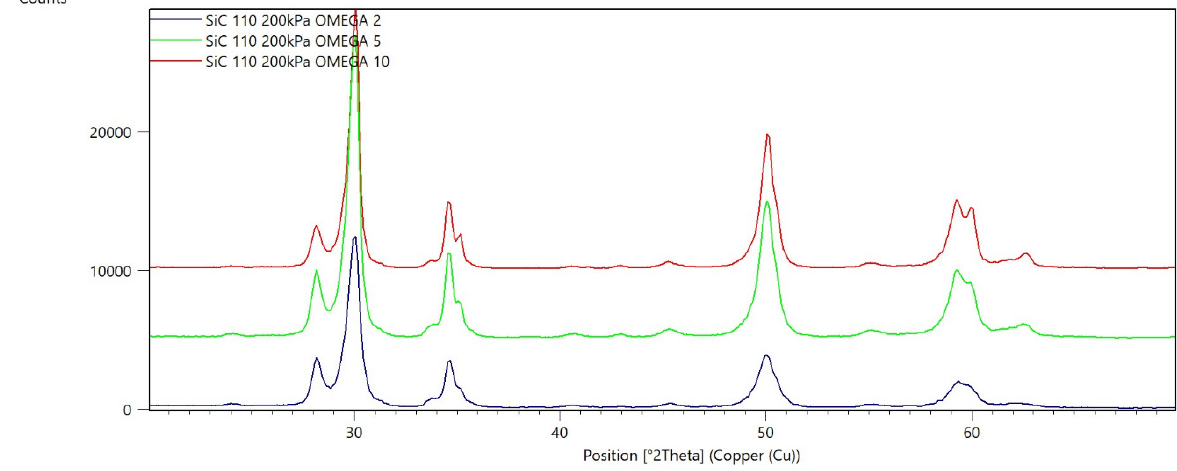
Figure 10. Diffraction patterns of sample I (abrasive—SiC 110 µ m, pressure 200 kPa).